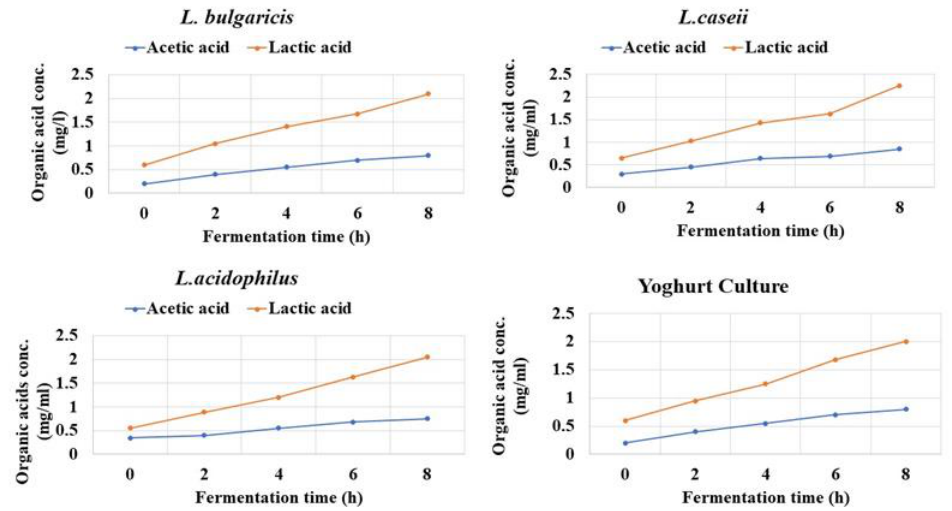
Figure 5. Acetic and lactic acid values of broken rice milk and the three LAB strains against commercial yogurt culture (control) during eight hours of fermentation, incubated at 37 °C.